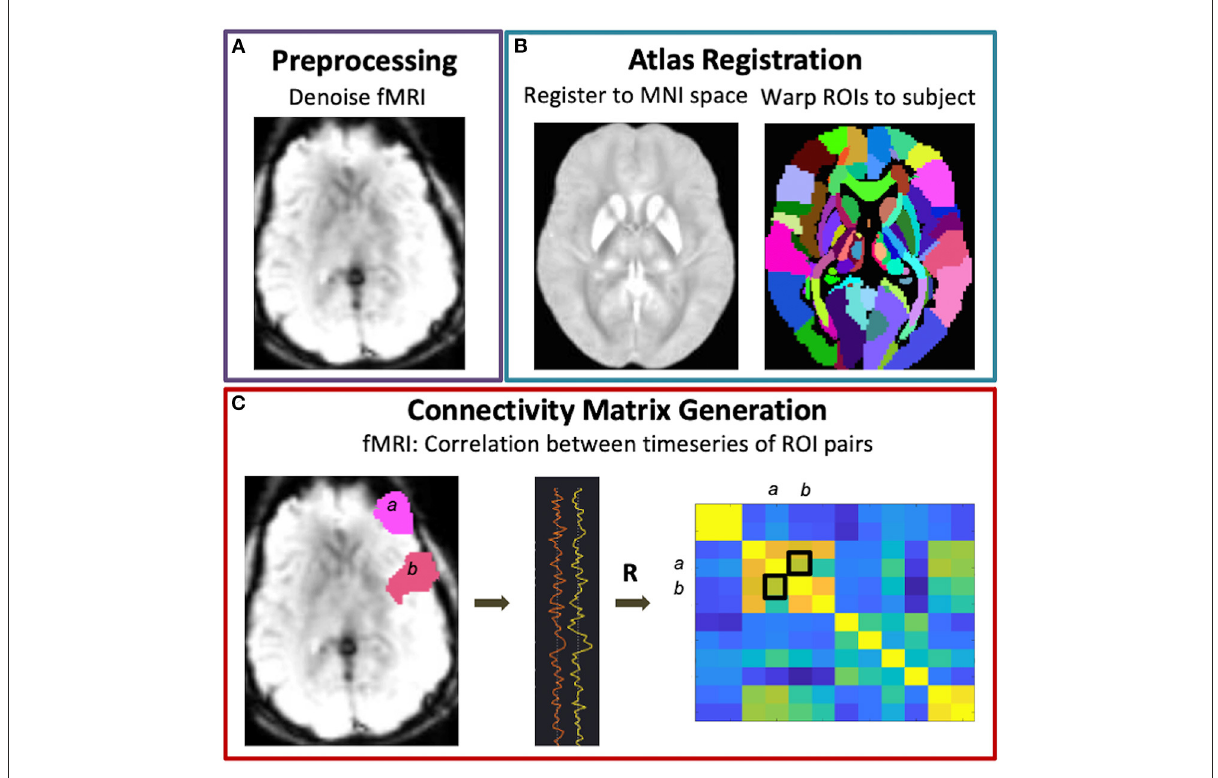
FIGURE1 Functional connectivity matrix generation. Following fMRI data preprocessing (A) and warping of the brain atlas regions-of-interest (ROIs) to subject space (B) , connectivity matrices were generated via Pearson correlations between all pairs of brain ROIs (C) .